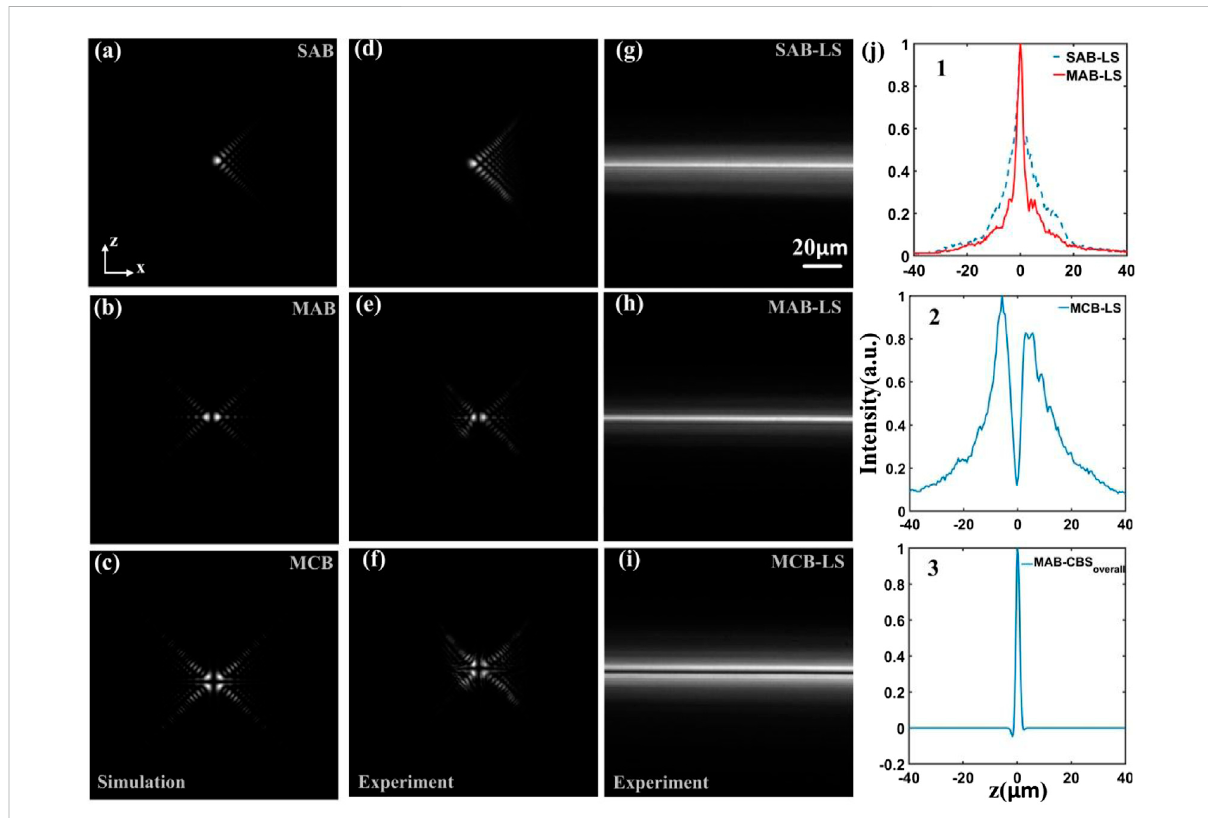
FIGURE 2 Numerical simulation and experimental measurement of the SAB, the MAB and the MCB. (A – C) numerical simulation in the transversal ( xz - plane) of the SAB, MAB and MCB, respectively. (D – F) experimental measurement of the transversal cross-sections. (G – I) The transversal ( xz -plane) cross-sections of the SAB light-sheet, MAB light-sheet and MCB light-sheet, respectively. The scan direction is along the x -axis. (J) The intensity pro fi les along the z -axis in (G – I)